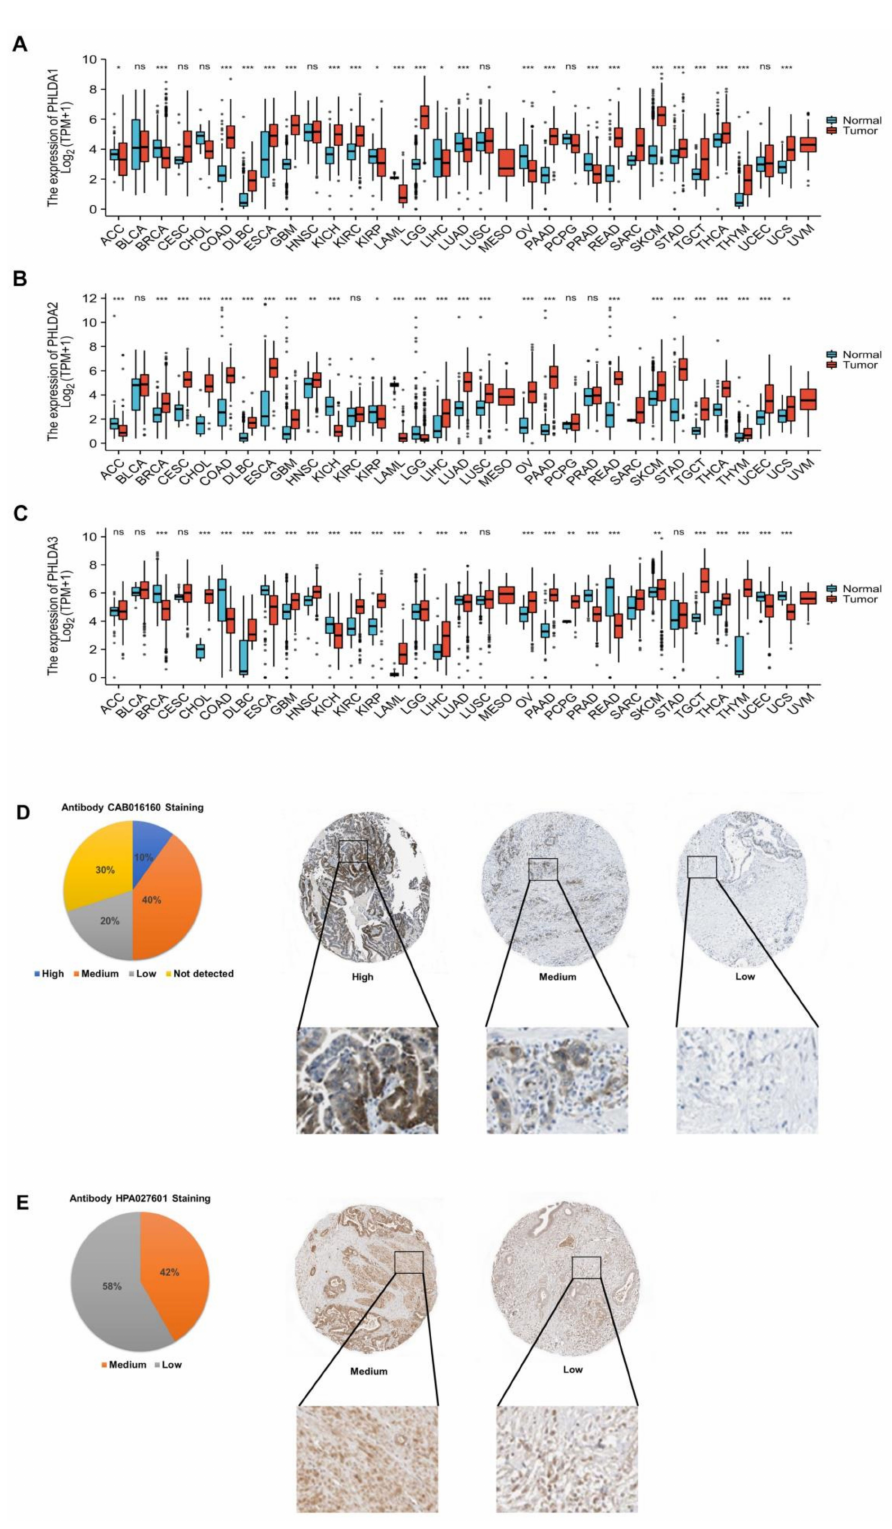
Figure 1. Expression analysis of the PHLDA family in pan-cancer and HPA analysis of PHLDA1/3 in PAAD. ( A ) The expression level of PHLDA1; ( B ) the expression level of PHLDA2; ( C ) the expression level of PHLDA3. ns, p ≥ 0.05; * p < 0.05; ** p < 0.01; *** p < 0.001. ( D ) The protein level of PHLDA1 (40 × ); ( E ) the protein level of PHLDA3 (40 ×